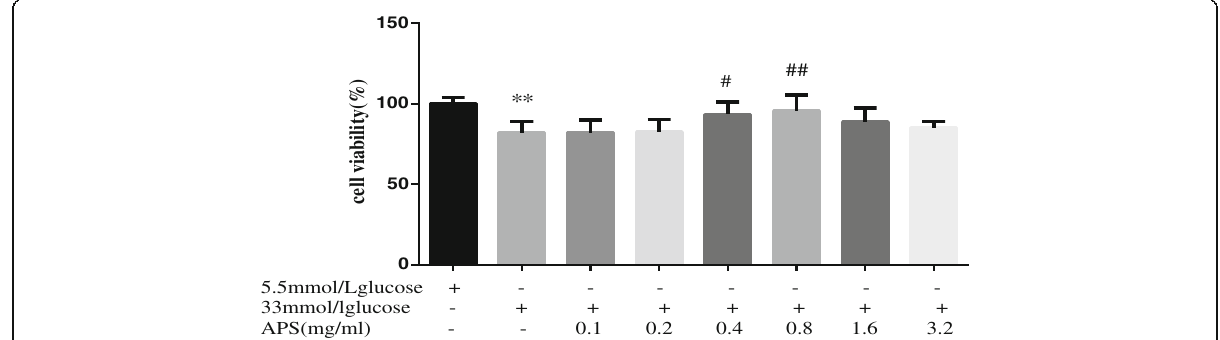
Fig. 2 Cell viabilities in cells treated with 5.5 mmol/L glucose, 33 mmol/L glucose or 33 mmol/L glucose in combination with different concentrations of APS (0.1, 0.2, 0.4, 0.8, 1.6 and 3.2 mg/mL) for 24 h. MTT assay was used to measure cell viability. Data were expressed as Mean ± SD. ** P < 0.01 versus control. # P < 0.05 versus 33 mmol/L glucose group. ## P < 0.01 versus 33 mmol/L glucose group